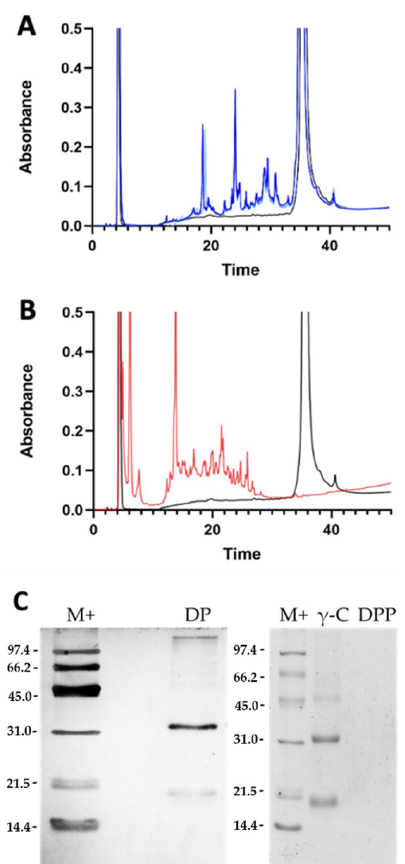
Figure 2. Analysis of the peptides obtained from γ -conglutin ( γ -C) in vitro digestion. ( A ) RP-HPLC profiles of digestion of γ -C with trypsin only. The black line is the undigested γ -C, whereas the light and dark blue lines indicate the products of trypsin proteolysis (DP) after 15 and 45 min of digestion, respectively. ( B ) RP-HPLC of the γ -C double digestion with pepsin and pancreatin (45 min). The black line indicates the undigested γ -C, whereas the red line relates to the digestion products with pepsin and pancreatin enzymes (DPP). ( C ) SDS-PAGE under reducing conditions of intact protein ( γ -C) and digested samples. DP: trypsin digested γ -C; DPP: pepsin and pancreatin digested γ